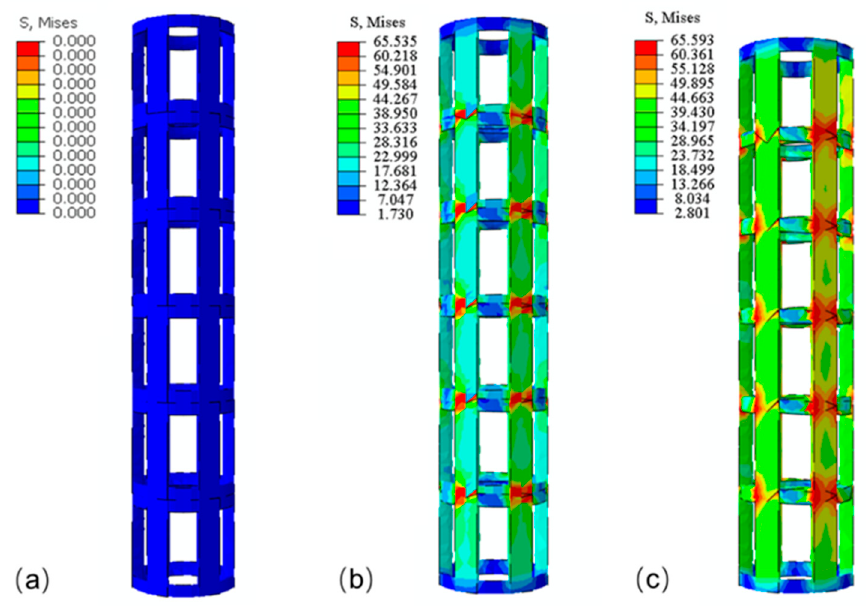
Figure 8. Evolution of deformation behavior of the bamboo uniform lattice structures predicted by FEA: ( a ) ε =0, ( b ) ε =0.01, ( c ) ε =0.03.